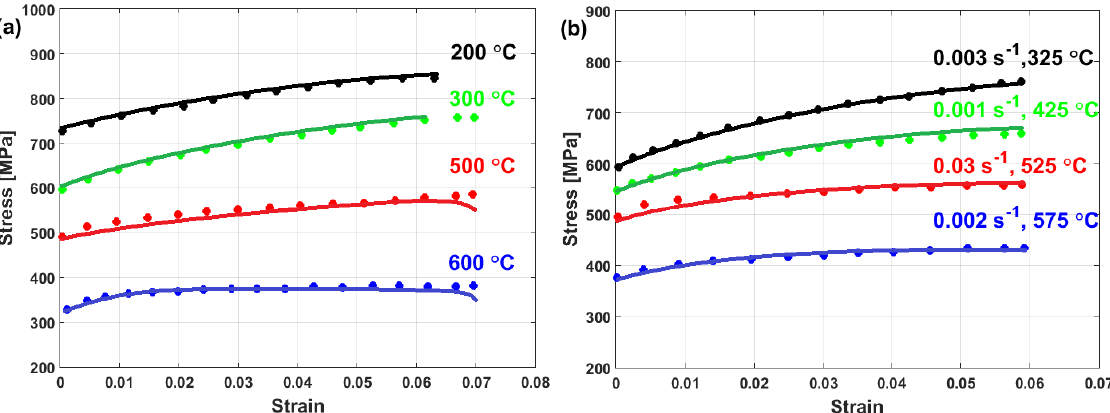
Figure 38. Experimental stresses (markers) compared to predicted stresses (solid lines) using the modified JC model that was presented by Tao et al. [63] for Ti−6Al−4V alloy for ( a ) the tested range of temperature and strain rates and ( b ) new experiments with different strain rates and temperatures for verification.